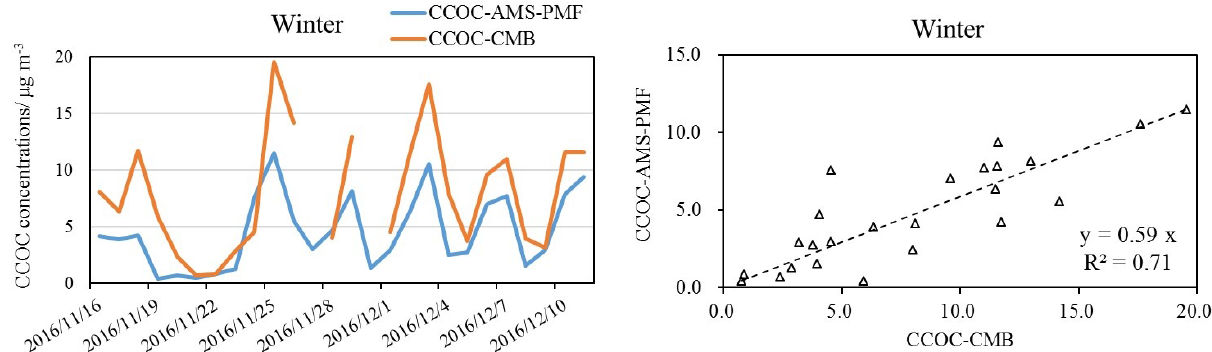
Figure 8. Time series and correlation of coal-combustion-related OC (CCOC) estimated by the CMB model and CCOC from AMS-PMF